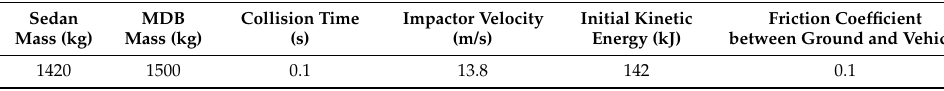
Table 4. Collision conditions for side crash